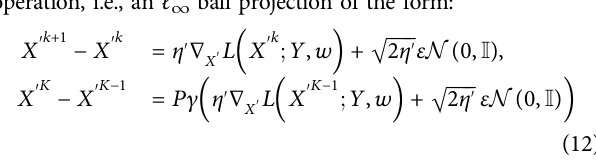
The highest two accuracy values in each column are highlighted in bold.